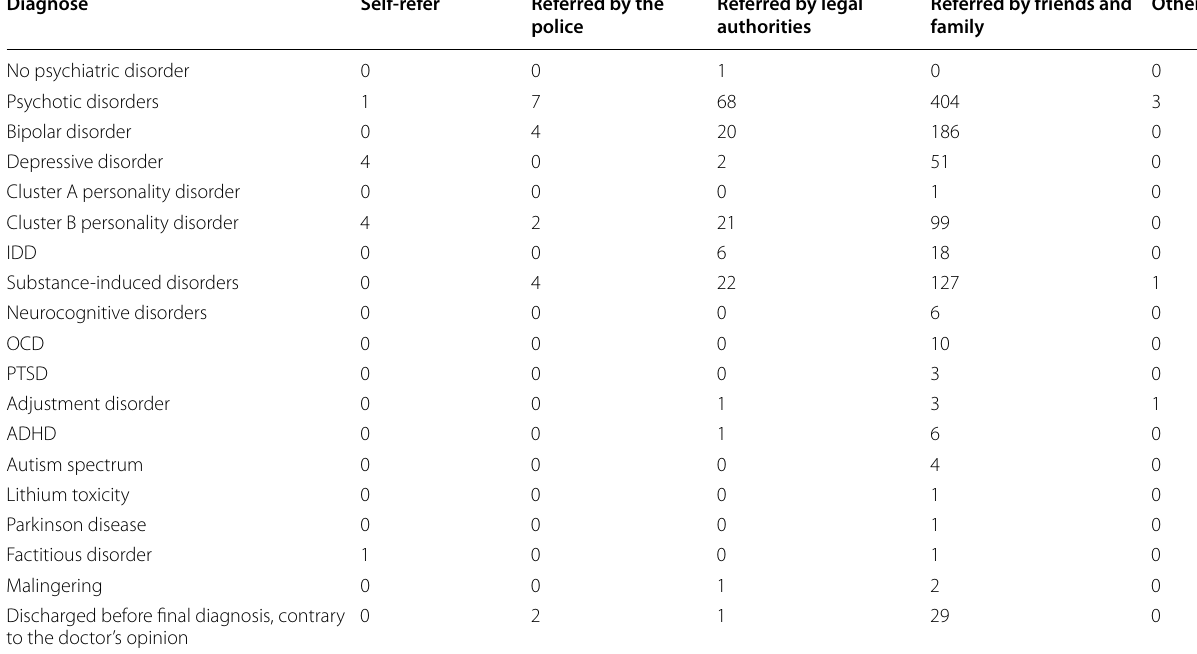
Table 4 Frequency of referrals by